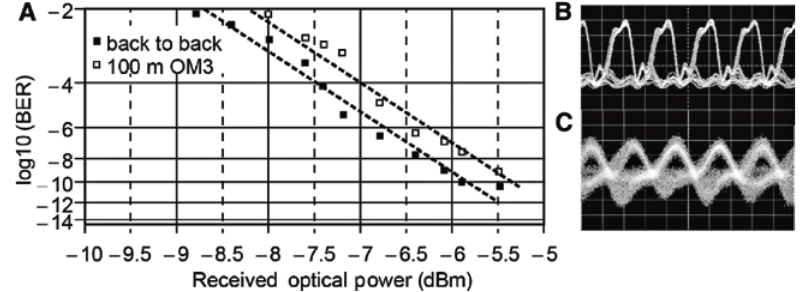
Figure 3: (A) Bit error rate and (B and C) RZ eye diagrams at 20 GHz and 850 nm EOM VCSEL (PRBS 2 7 − 1) at 10 Gb/s. (B) Electric eye. (C) Optical eye.